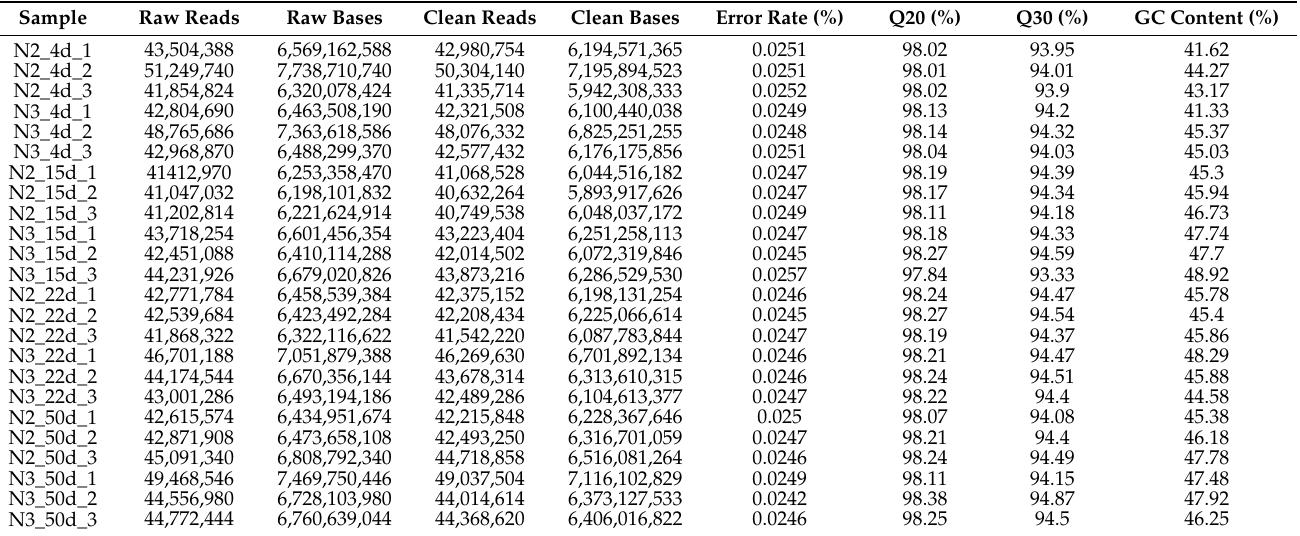
Table 2. Characteristics of sequence